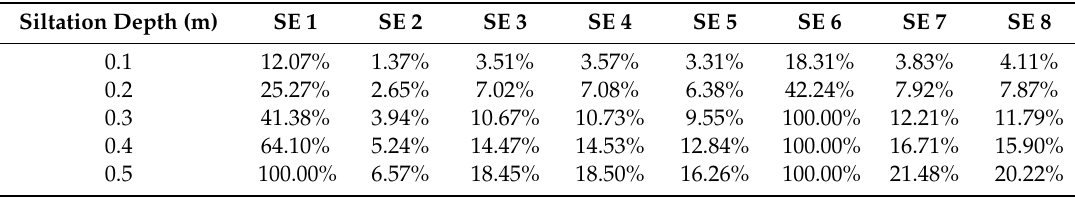
Table 6. Reduction ratio of e-flow requirement for di ff erent river segments (SE) under the medium hydrological connectivity